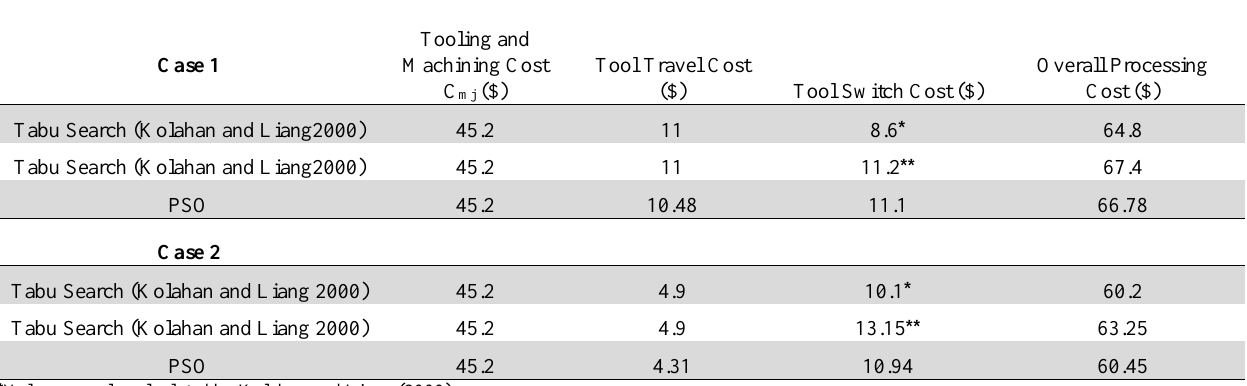
Comparison of results of optimization obtained by using PSO with those obtained by using tabu search Kolahan and Liang (2000) for Case 1 and Case